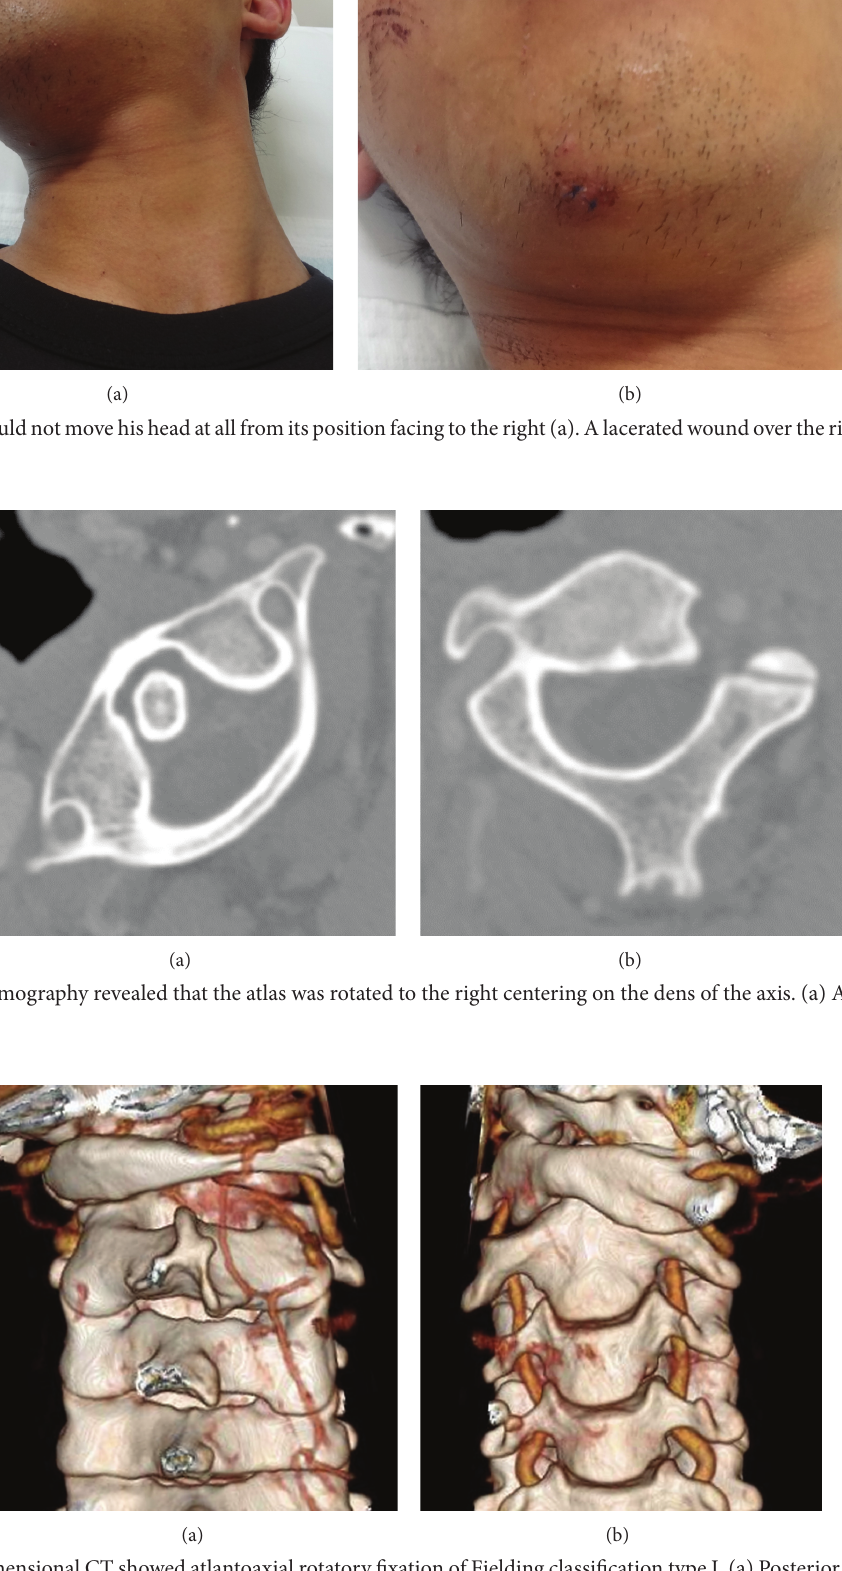
Figure 3: The three-dimensional CT showed atlantoaxial rotatory fixation of Fielding classification type I. (a) Posterior view and (b) anterior